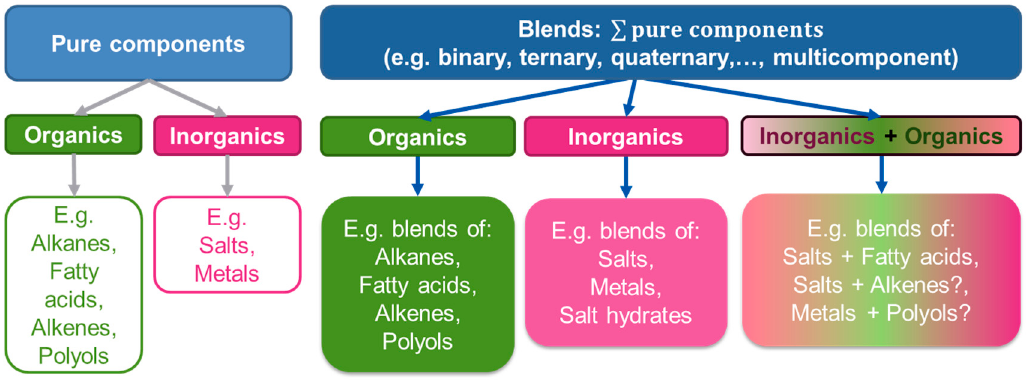
Figure 2. Categories of PCMs based on their origin and number of components (i.e., unary, binary, ternary, onwards up to multicomponent blends).